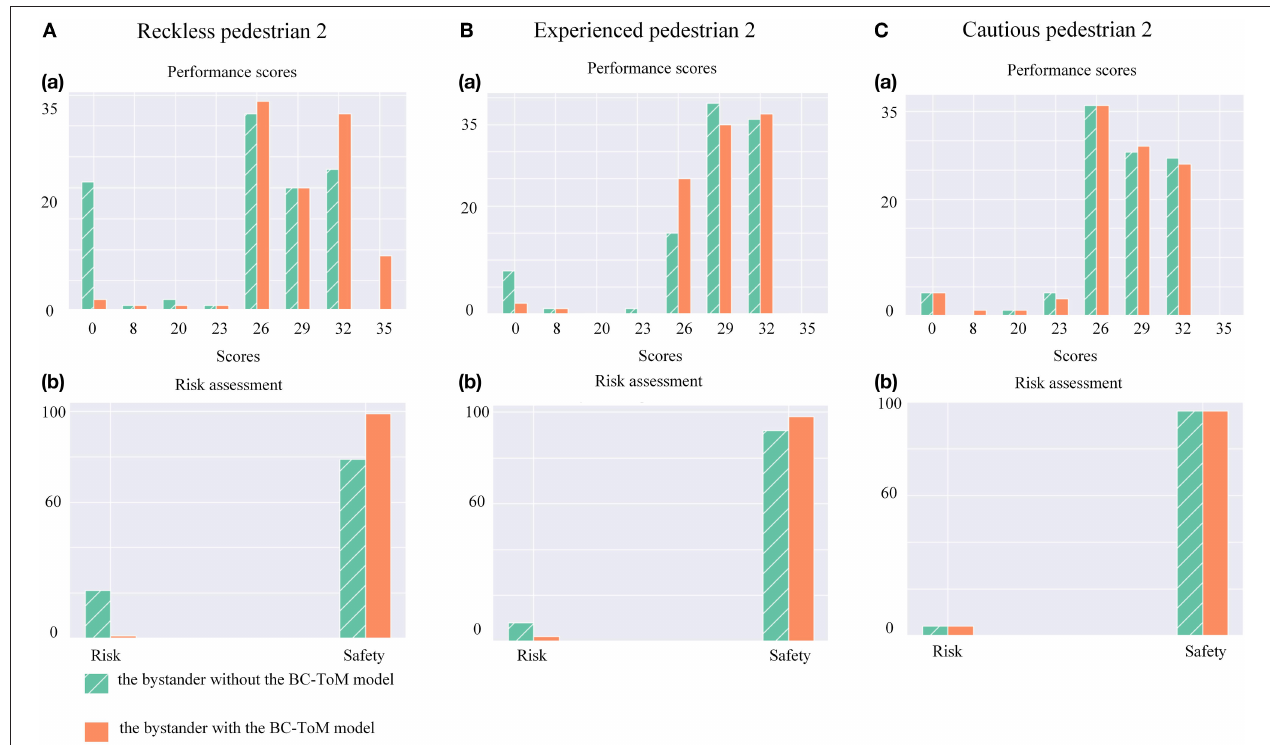
FIGURE 8 | (A) (a) Histograms of reckless agents’ performance scores. (b) Histograms of reckless agents’ risks assessment. (B) (a) Histograms of experienced agents’ performance scores. (b) Histograms of experienced agents’ risks assessment. (C) (a) Histograms of cautious agents’ performance scores. (b) Histograms of cautious agents’ risks assessment.